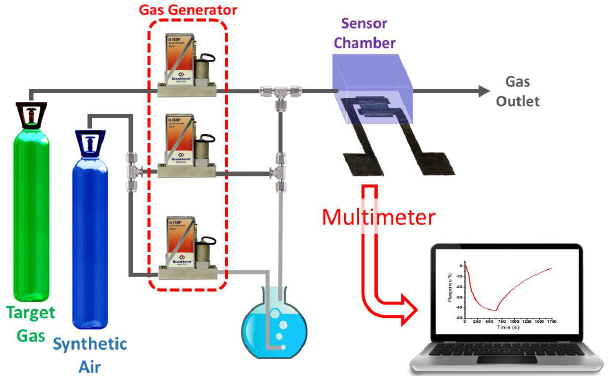
Figure 2. Experimental setup used to measure different gases concentrations with the WS 2 -on-paper sensor in real time.